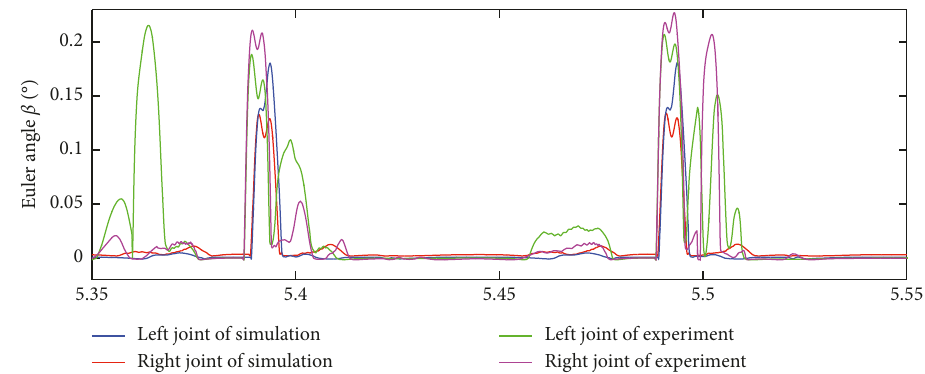
Figure 17: Euler angle β for the two joints in simulation and experiment.